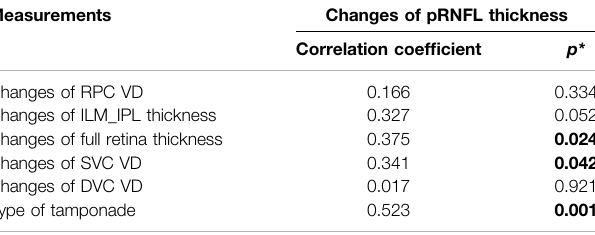
Bold values indicate statistically signi fi cant differences. *p valuesrefertoSpearman ’ scorrelationanalysisexploringthecorrelationsbetweenthe changes in pRNFL, thickness and other variables. pRNFL, peripapillary retinal nerve fi ber layer; RPC, radial peripapillary capillaries;